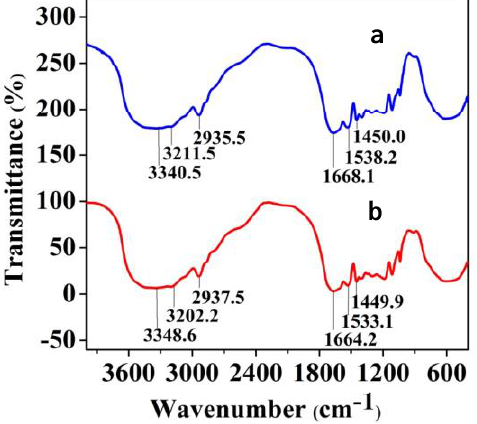
Figure 2. FTIR spectra of (a) MIP and (b) NIP.